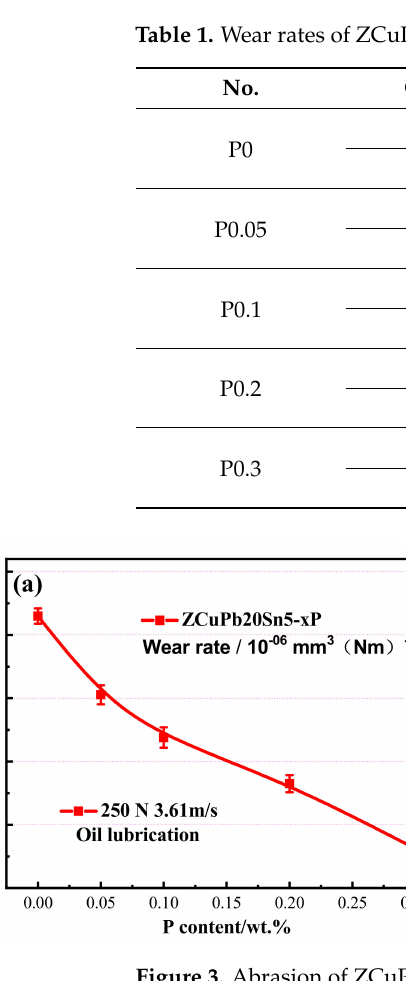
Figure 3. Abrasion of ZCuPb 20 Sn 5 − x P alloy and 45 # steel disc under oil lubrication ( a ) wear rate